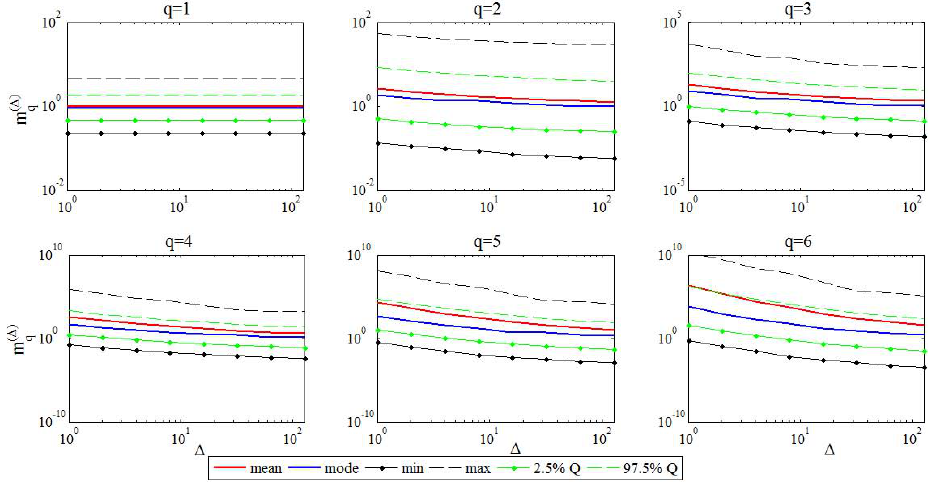
Fig. 6. Log-log plots of the prediction intervals of the sample moments versus the scale 1 for various orders q